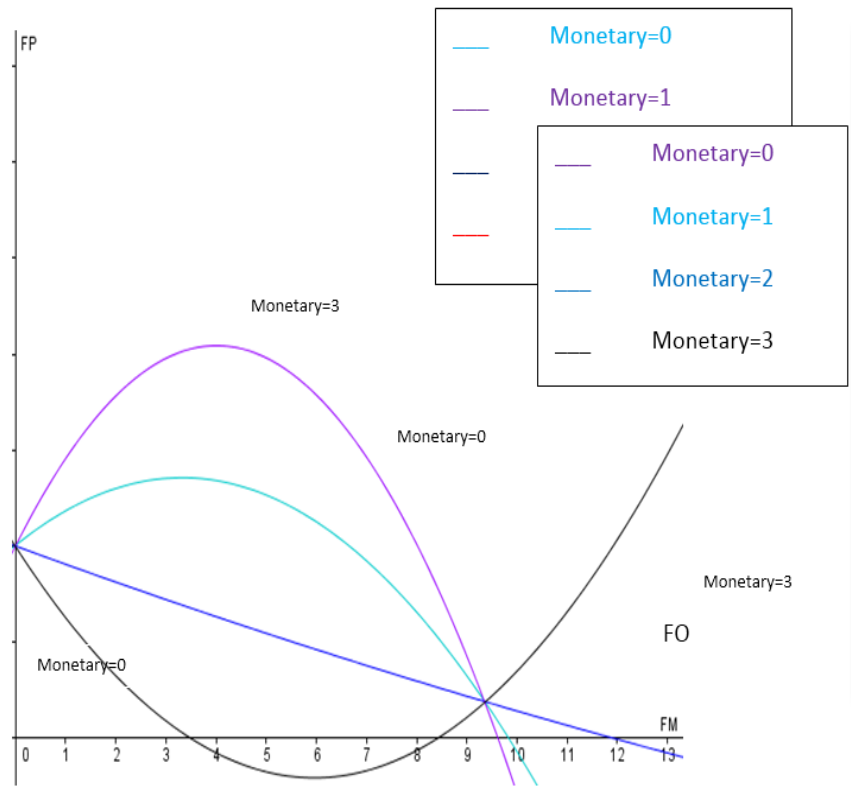
Figure 6. Significant Interactions between Family Management and Monetary Provision. The negative moderation effects of Monetary Provision changes the direction of inverted U-shaped relationship between Family Management and Firm Performance into a